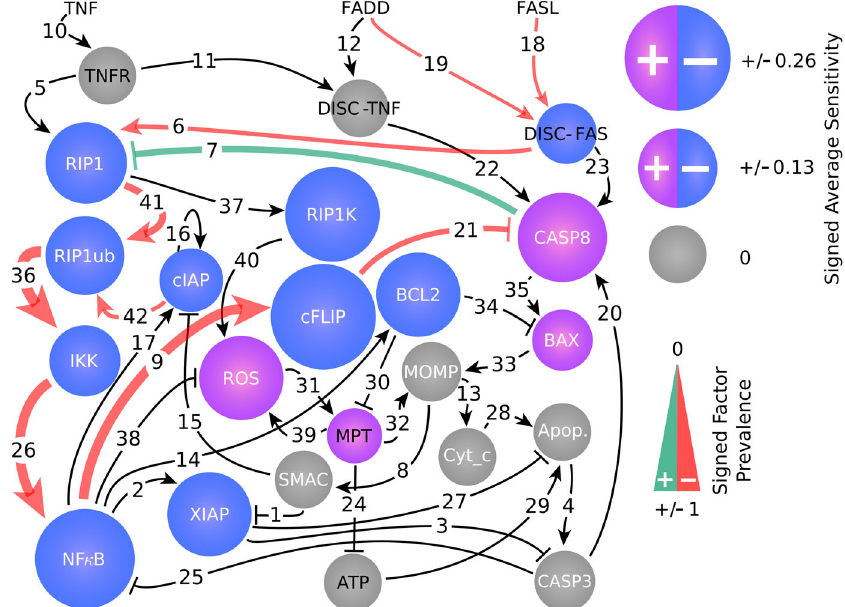
FIG. 4. Optimal therapeutic interventions for the cell death regulatory network model. The network has 22 genes (circles), 3 input parameters (top), and 42 target tunable parameters (edges), where the edge heads distinguish between excitatory (arrow) and inhibitory (bar) regulatory interactions. OLAC is applied to induce a bifurcation transition from survival to apoptotic states. The parameters involved in one or more optimal intervention are consistently upregulated (green) or downregulated (red) by the interventions; those not recruited by any optimal intervention are shown in black. The edge width indicates the prevalence of that parameter in optimal interventions for the various cell types and intervention strengths considered (up to the elimination of the survival state). The size of each circle represents the sensitivity of the gene to proapoptotic interventions, defined as the change in gene expression between the uncontrolled scenario and the smallest intervention scenario at which the survival state is eliminated; the color distinguishes up and down expression. Genes in white are those that change expression substantially between the survival and apoptotic states. These results are based on 6 simulated cell types and 9 different intervention strengths (see Supplemental Material [20], Fig.